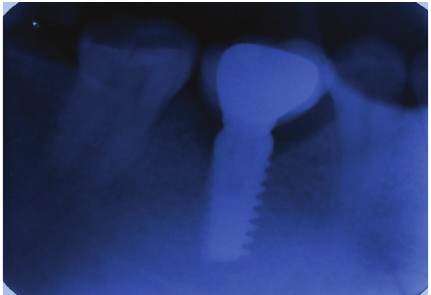
Figure 8: PVS impression.